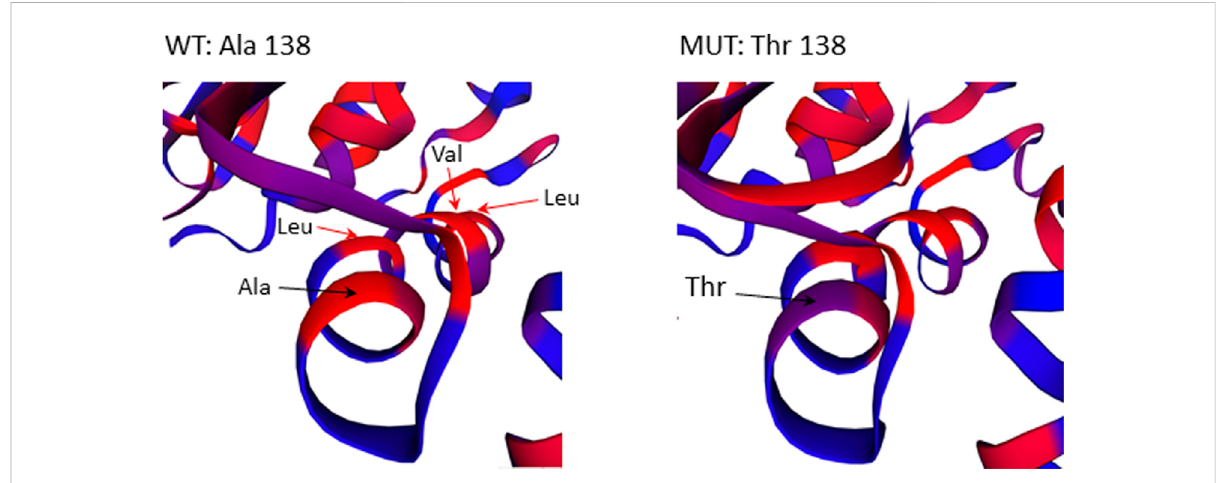
FIGURE 5 Close-upviewofresiduessurroundingAla138Thrinthe3DstructureoftheGBP2protein.SubstitutionofAlawithmorehydrophilicThrreduces the stretch of hydrophobicity along one side of the α